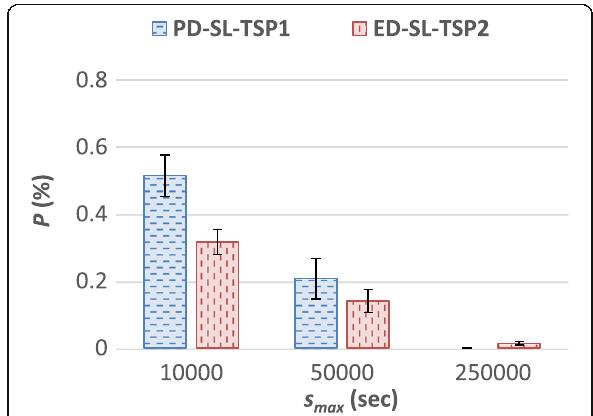
Fig. 8 Effect of s max on P when using the CyberShake workload